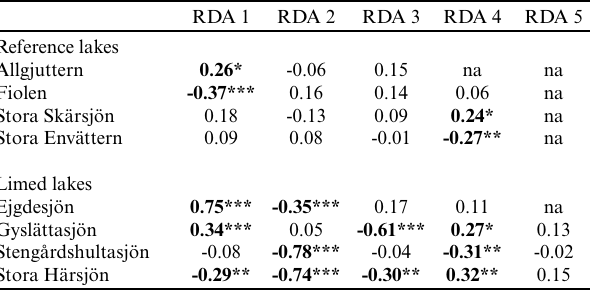
Table 2 . Spearman rank correlation analysis associating temporal patterns determined by AEM-RDA and Ca:Mg ratios. Shown are correlation coefficients (rho). Significant correlations (highlighted in bold) where * p < 0.05; ** p < 0.01; *** p < 0.001. Not applicable (na) because axes were not significant.